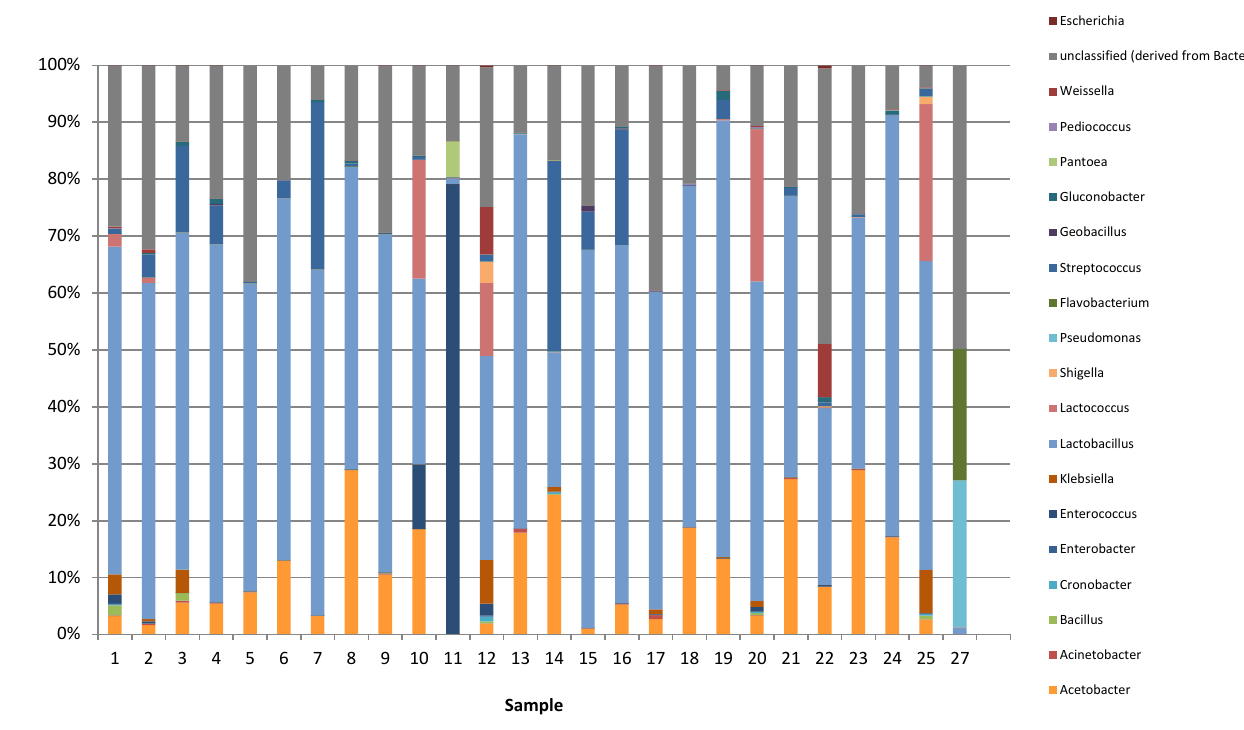
Figure 2. Relative abundance of microorganisms in 25 nono samples obtained from local Fulani processors and markets in Kano, Katsina, Jigawa, and Bauchi states in northern Nigeria, as determined by 16S-based amplicon sequencing.